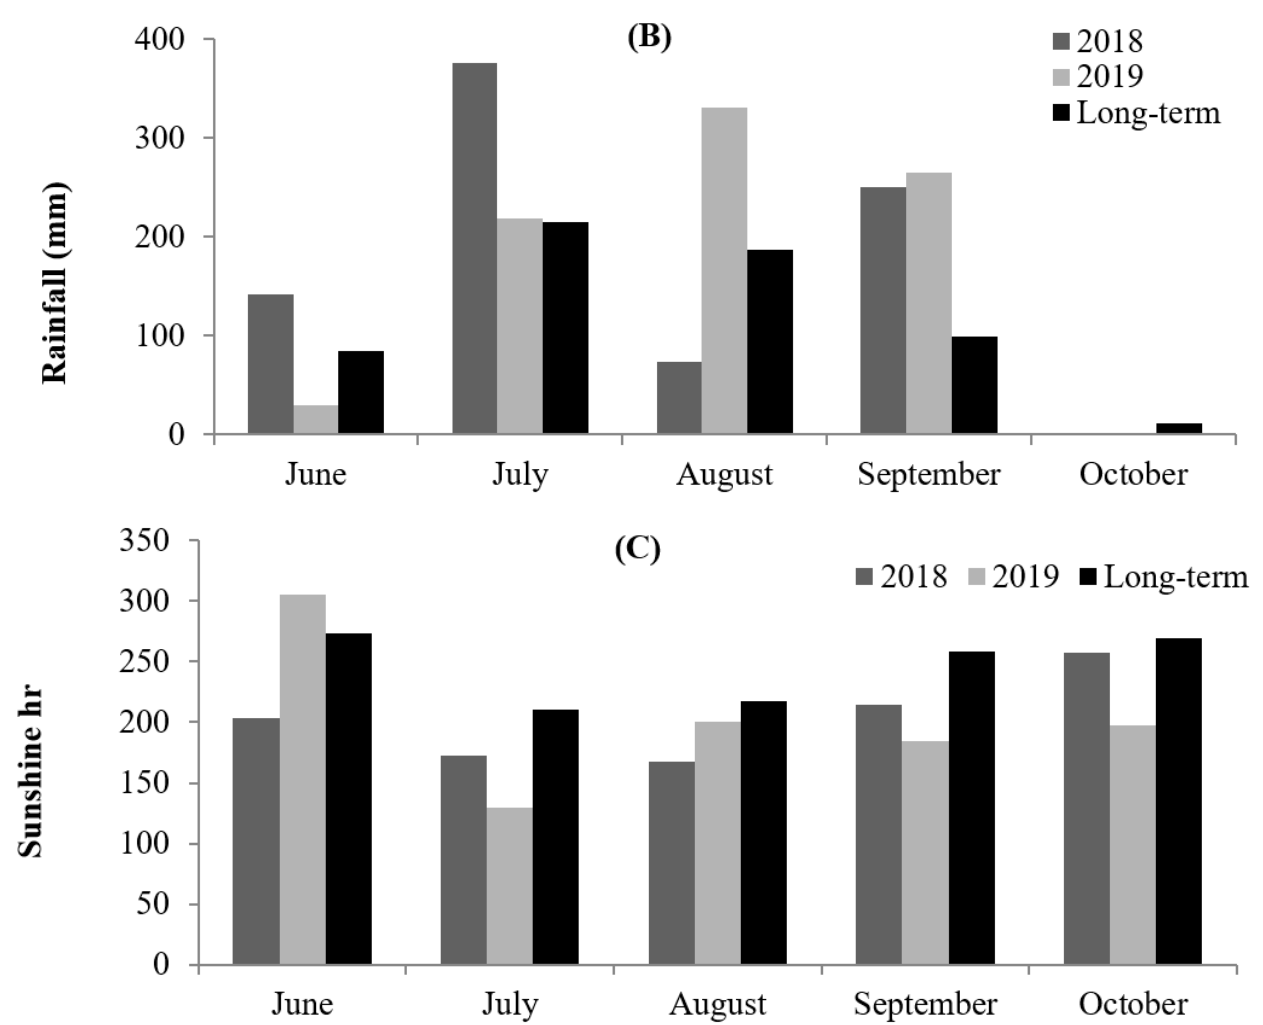
Figure 1. Mean monthly ( A ) temperature (minimum, maximum, and mean), ( B ) rainfall, and ( C ) sunshine hours during the study period (2018 and 2019 season) and of 10 year long-term average.